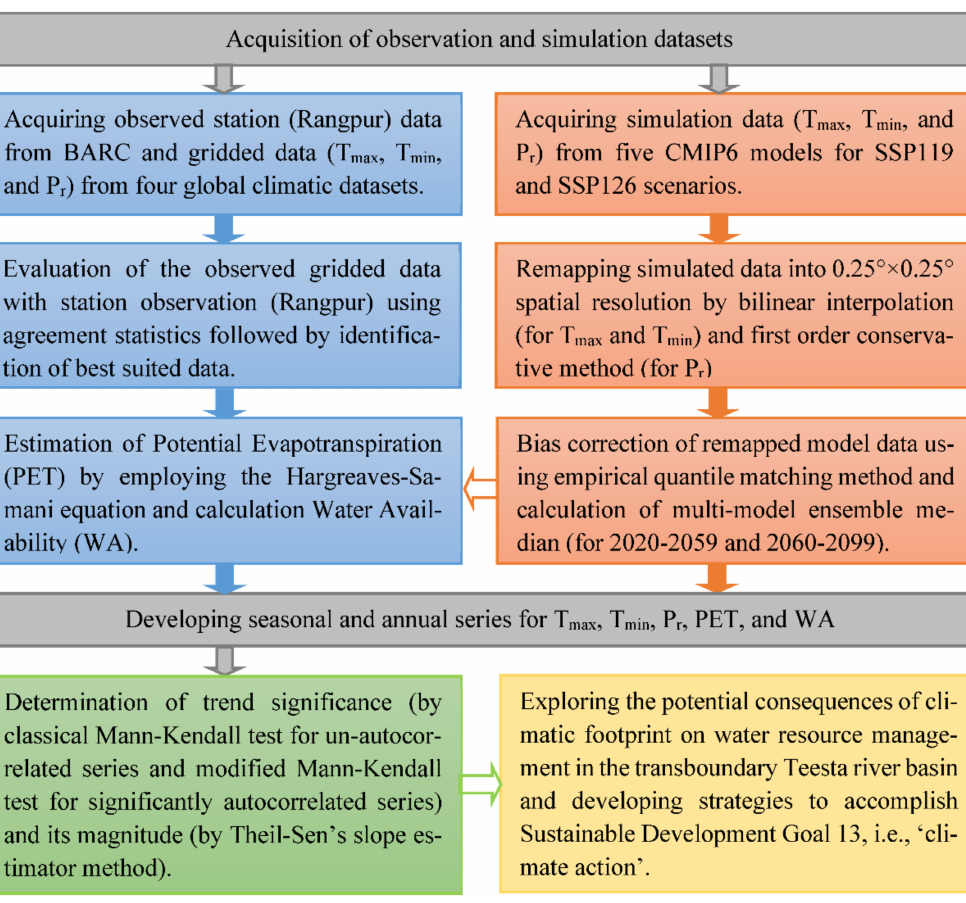
Figure 2. Description of the methodology followed in the